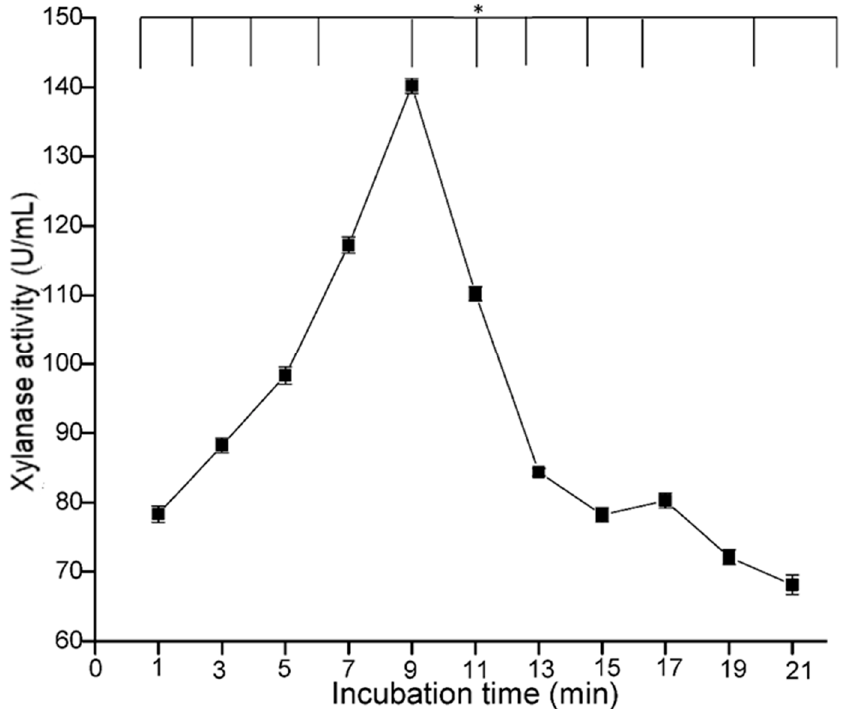
Figure 12. Effect of incubation time on xylanase production by B. safensis XPS7. All the experiments were performed in triplicate. Line graph display mean ± SD and statistical analysis was performed using a one-way ANOVA with a Tukey post hoc test, with p < 0.01 *.